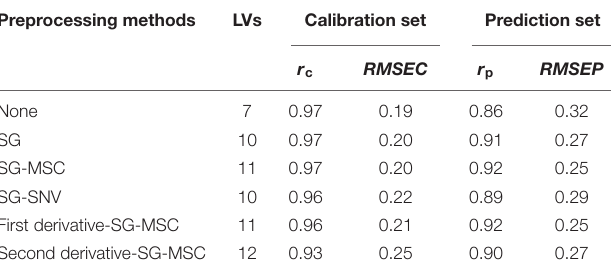
TABLE 2 | Prediction results of SSC by PLS models combined with different preprocessing